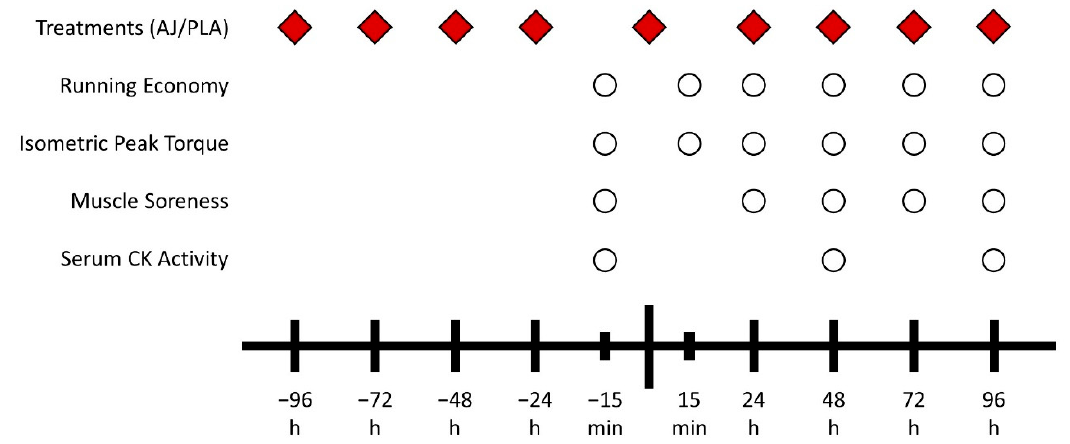
Figure 1. The experimental design of the study. The biggest dash represents downhill running. AJ: antioxidant juice; PLA: placebo; CK: creatine kinase.